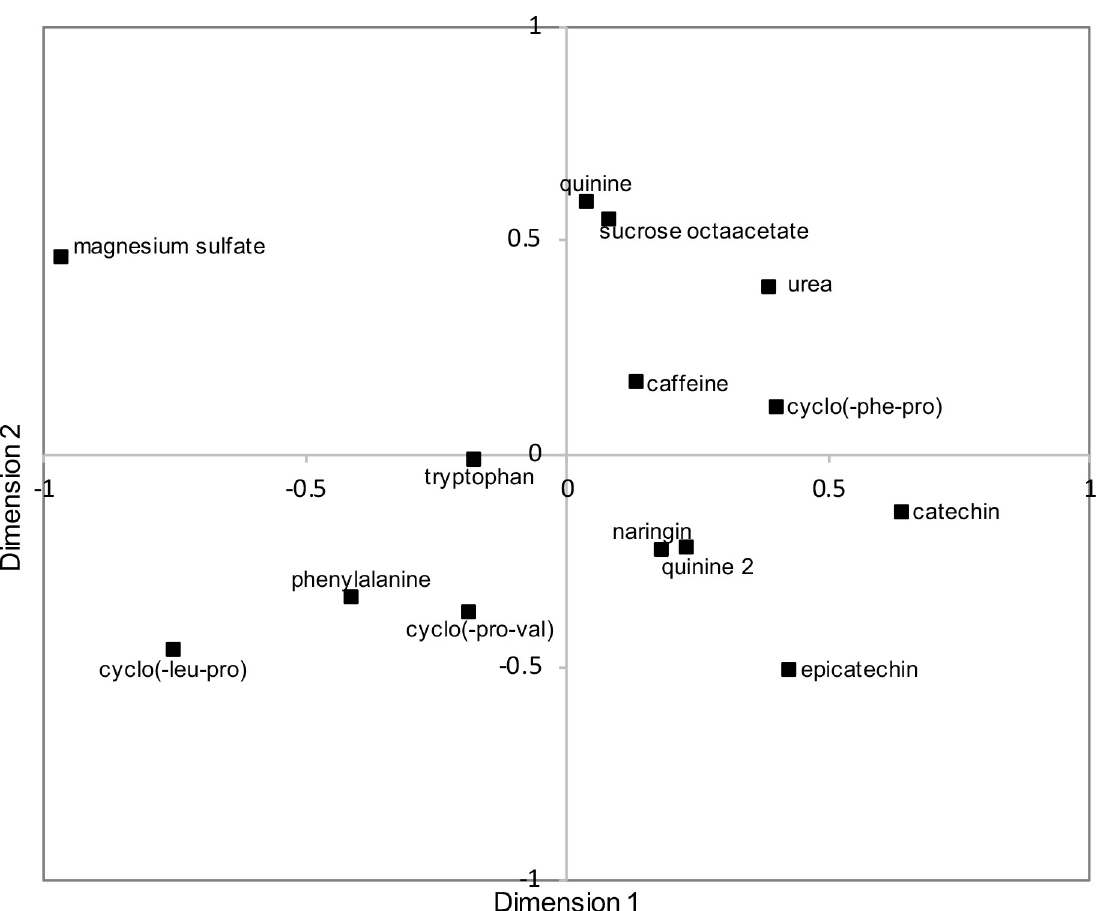
Fig 3. Perceptual map from Multidimensional Scaling (MDS) from similarity matrix obtained from napping experiments (Tucker’s coefficient of congruence = 0.984).